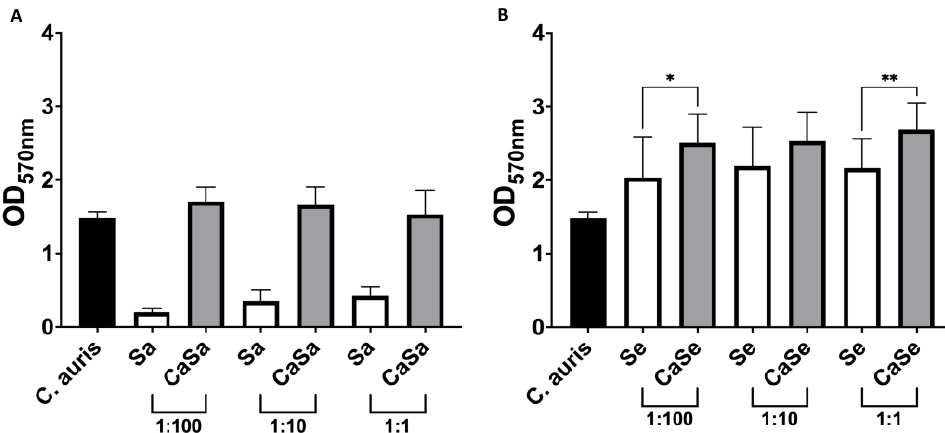
Figure 1. Staphylococcus aureus does not influence biomass of dual-species biofilms. Biofilms were grown in growth media at varying ratios of bacteria to fungi. The concentration of C. auris (Ca) remained constant at 1 × 10 6 cells/mL whereas S. aureus (Sa; A ) and S. epidermidis (Se; B ) were added to growth media at final concentrations of 1 × 10 4 , 1 × 10 5 and1 × 10 6 cells/mL. Ratios provided below the x -axis indicate the number of bacterial to fungal cells. Biofilms were washed with PBS and stained with crystal violet before measuring the absorbance of bound dye at 570 nm. Experiments were performed in triplicate and error bars represent the standard deviation of the mean (*; p < 0.05 **; p < 0.01).